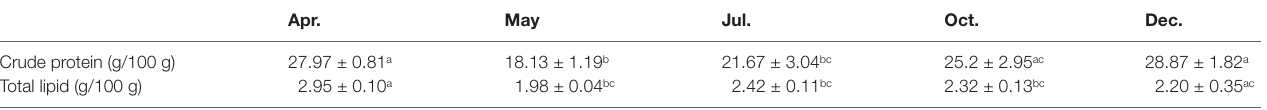
TABLE 2 | Crude protein and total lipid of Stichopus monotuberculatus body wall from April to December 2019. Apr. Jul.